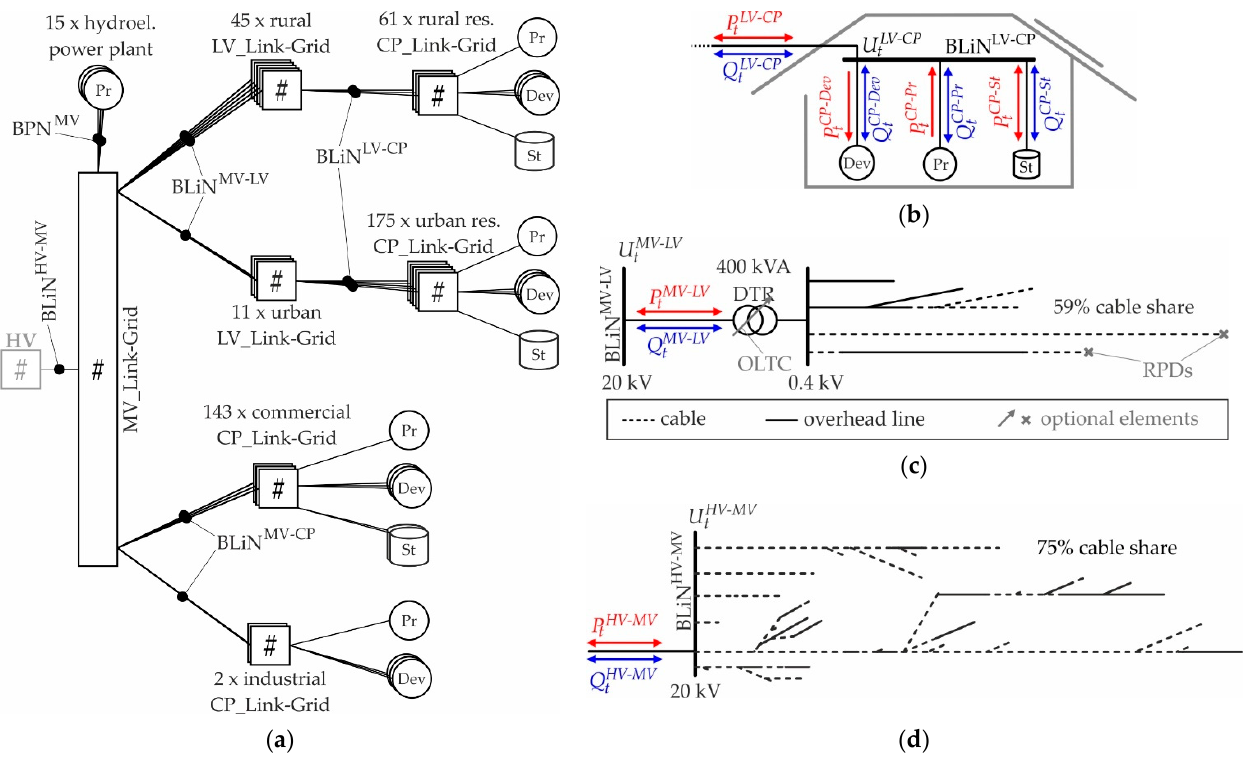
Figure 4. Structure of the test link chain: ( a ) overview; ( b ) residential CP_Link-Grids; ( c ) rural LV_Link-Grid; ( d ) MV_Link-Grid.